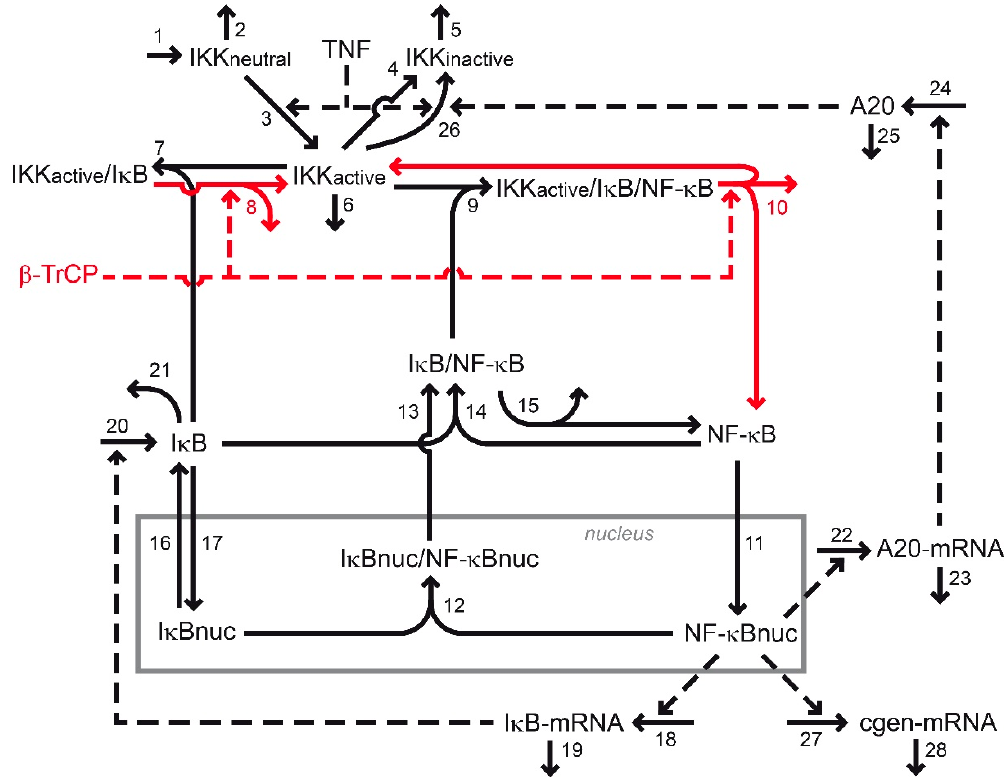
Figure 1. Reaction scheme underlying the model of canonical NF- κ B signaling. Reactions and pathway components of the original model [34] are shown in black; reactions involving β -TrCP-mediated I κ B degradation are highlighted in red indicating model extensions. The nuclear species of the model are surrounded by the grey box. The numbers next to the arrows specify the number of the reaction. One-headed arrows denote reactions taking place in the indicated direction. Dashed arrows illustrate activations. Components in a complex are separated by slashes. The Methods Section provides additional explanations; Document S1 lists reaction rates and parameters of the model. cgen: Control gene; nuc: Nuclear.